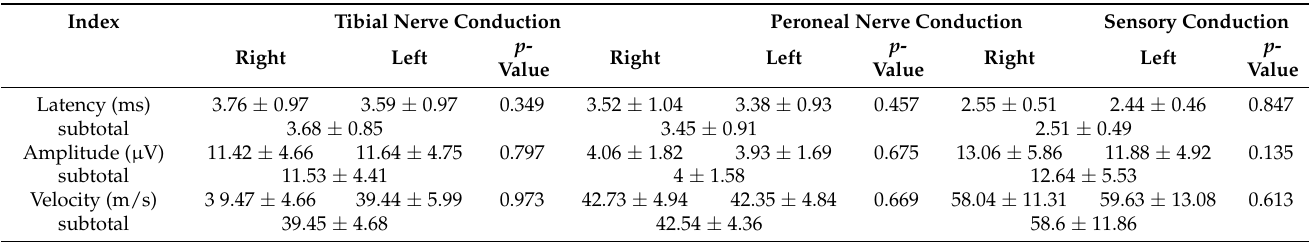
Table 2. Mean values of the motor/the sensory conduction parameters of the tibial nerve and the peroneal nerve of subjects.